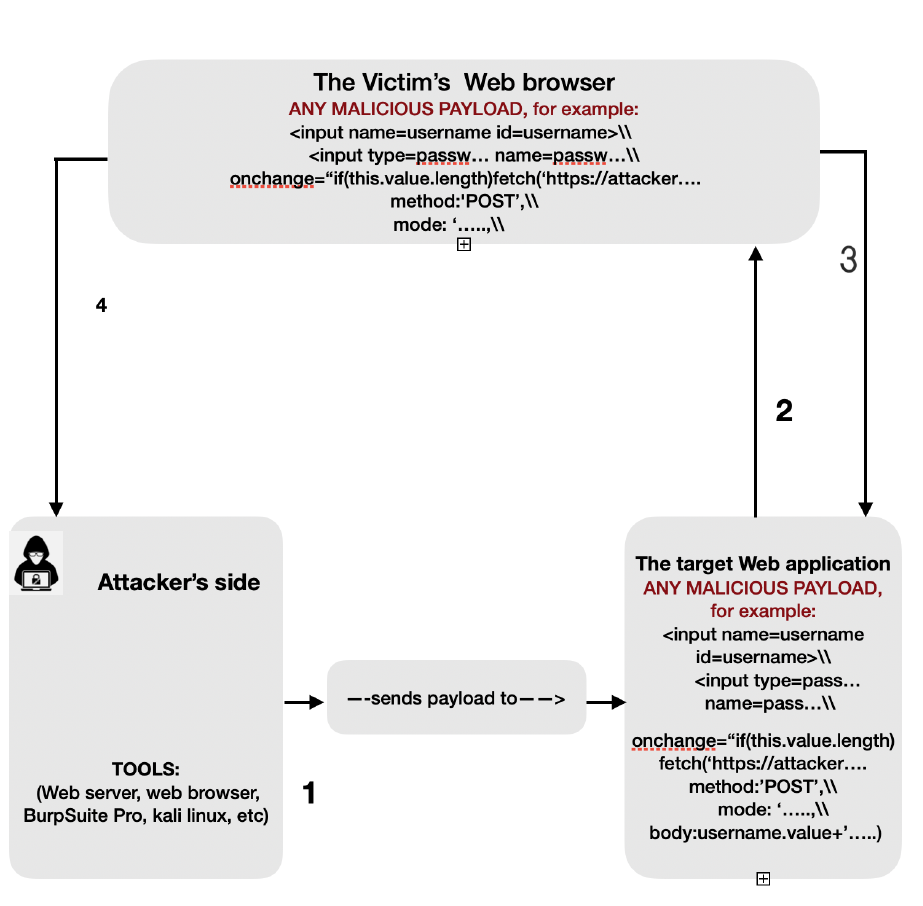
Figure 1. Stored XSS